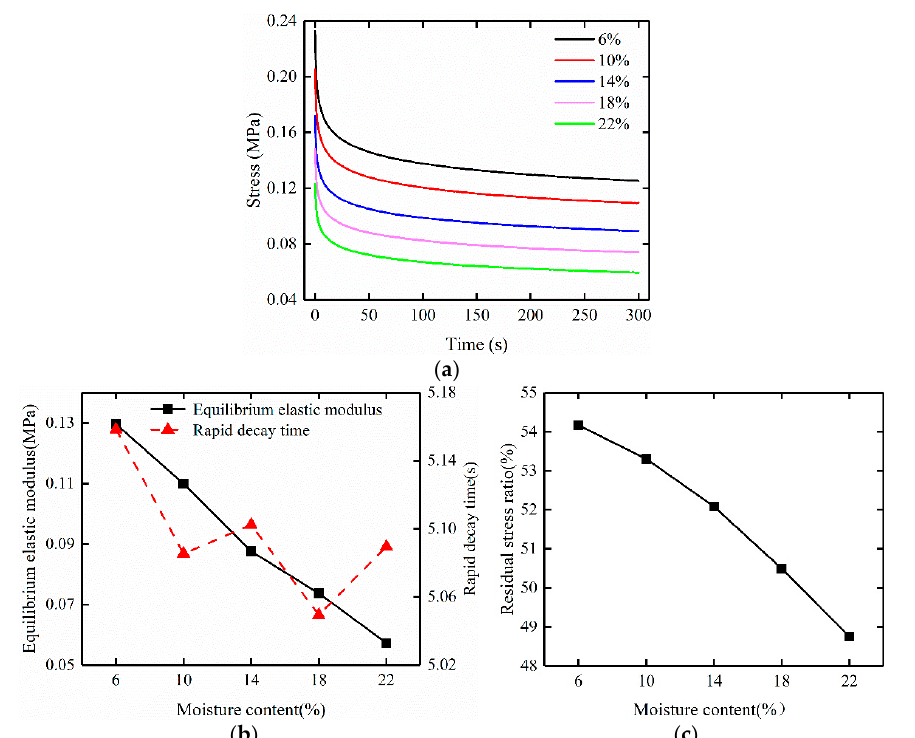
Figure 4. Stress relaxation characteristics at different moisture contents: ( a ) Stress relaxation curve; ( b ) Equilibrium elastic modulus E e and rapid decay time T 1 ; ( c ) Residual stress ratio ε .